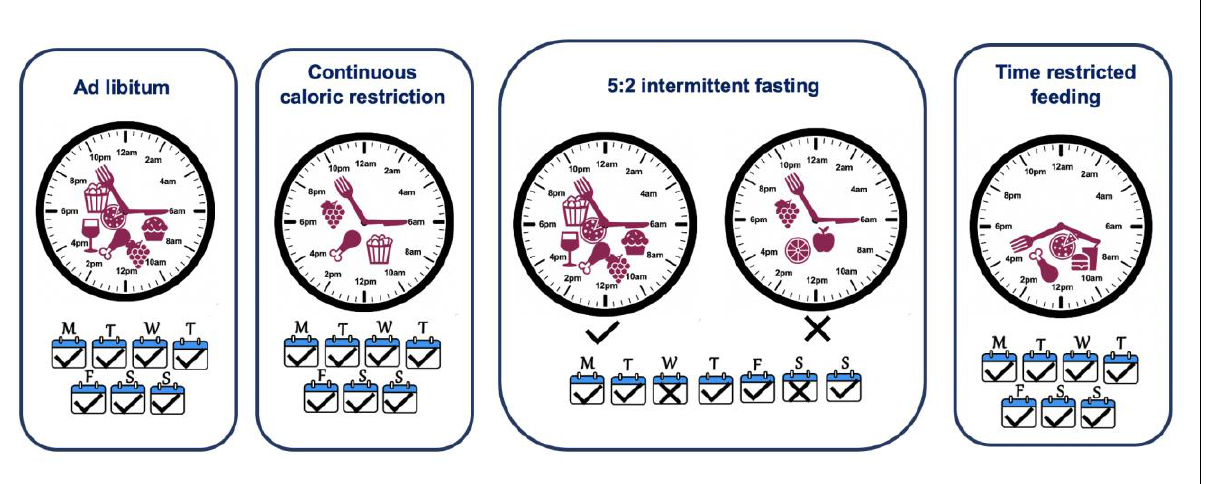
Figure 3. Dietary weight-loss approaches. Continuous caloric restriction includes reducing caloric intake on each day of the week but does not restrict time of the day. Intermittent fasting, e.g., 5:2 diet, introduces two caloric restriction days with ad libitum eating for the rest of the week. Time-restricted feeding limits the eating window and extended fast period regularly.